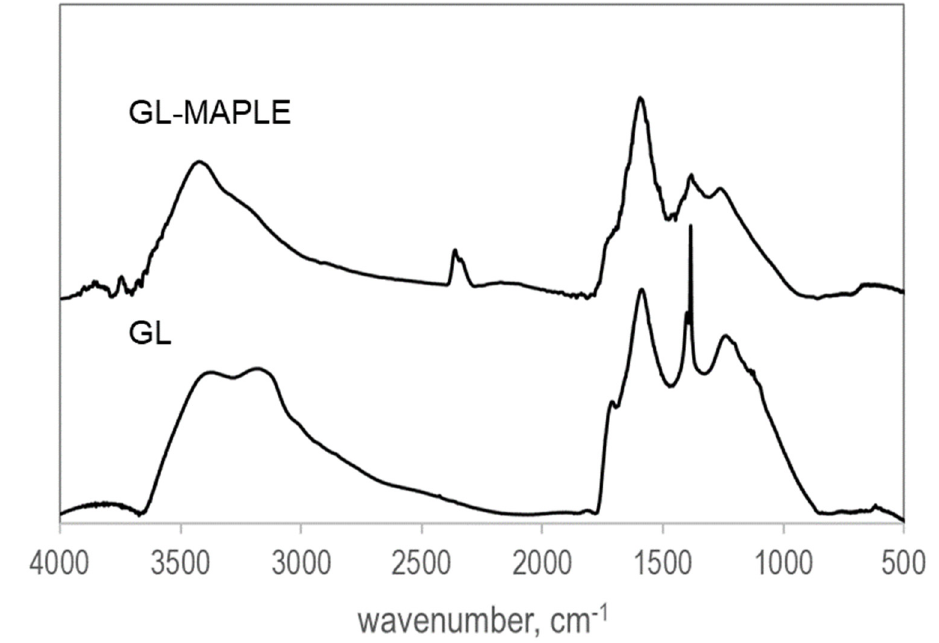
Figure 2. FTIR spectra of the GL and GL-MAPLE (laser pulse energy: 350 mJ/pulse) in the 500–4000 cm − 1 region.